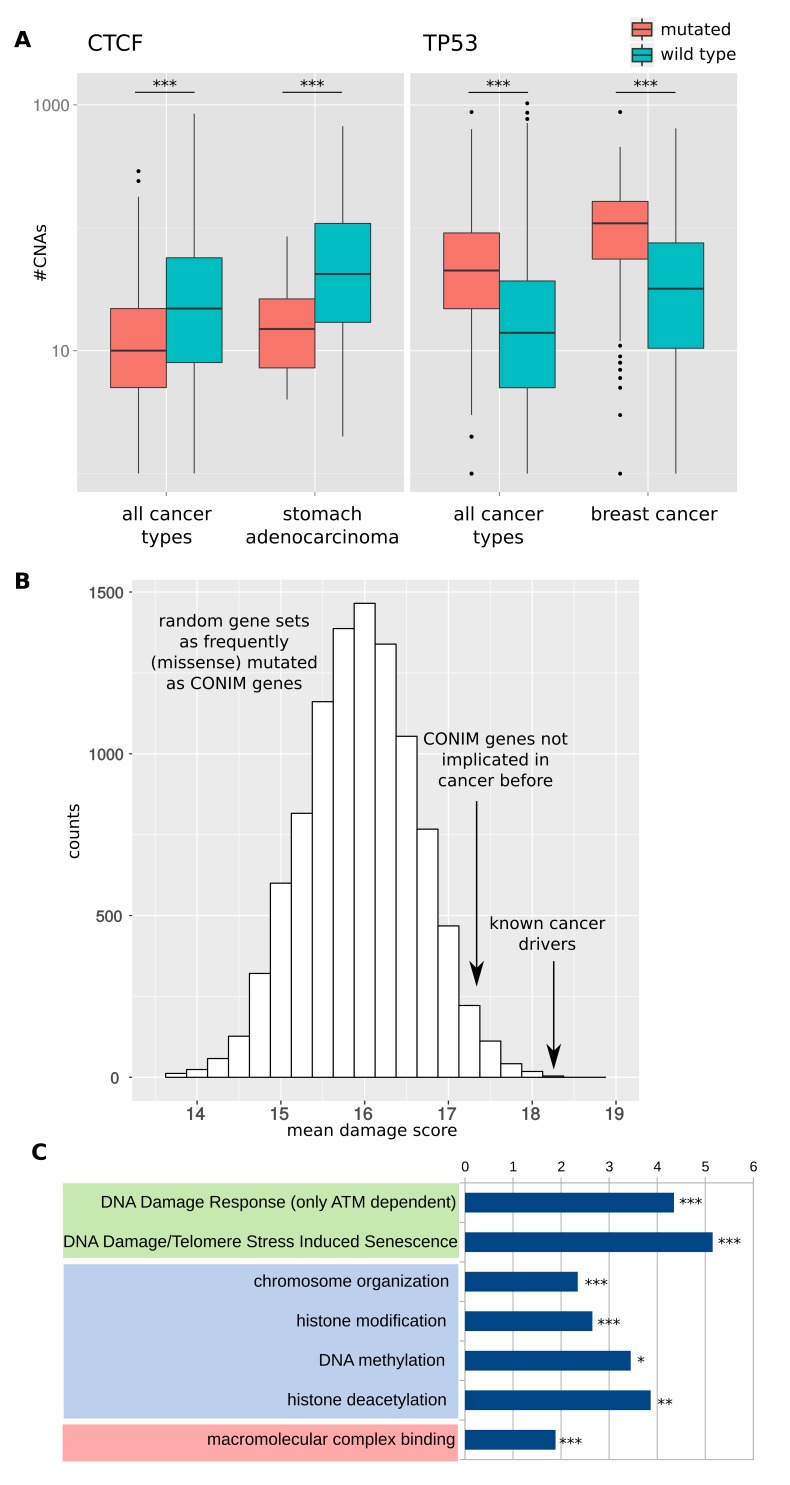
Detection and functional properties of CONIM genes.(A) CNA numbers in samples in which CTCF (left box) or TP53 (right box) are mutated versus samples in which the respective gene is not mutated. The CNA number distributions are shown for all cancers types (left whiskers within each box) and for a single cancer type (right whiskers within each box). (B) Mutations in CONIM genes tend to have a higher functional impact than mutations found in genes with an equal mutation frequency. Even CONIM genes not previously reported (Lawrence et al., 2014) to be frequently mutated in cancer tend to host mutations with a higher functional impact score (mean 17.23) as compared to random gene sets having matched mutation numbers (p = 0.029; randomisation test). For comparison, the most frequently mutated cancer-driver genes have a mean score of 18.31. (C) The functional categories most significantly overrepresented among the CONIM genes are shown. Among the most highly enriched categories are several terms related to DNA damage (green), chromatin organisation (blue) and complex formation (red). Significance levels are indicated as follows: **q < 0.01, ***q < 0.001.